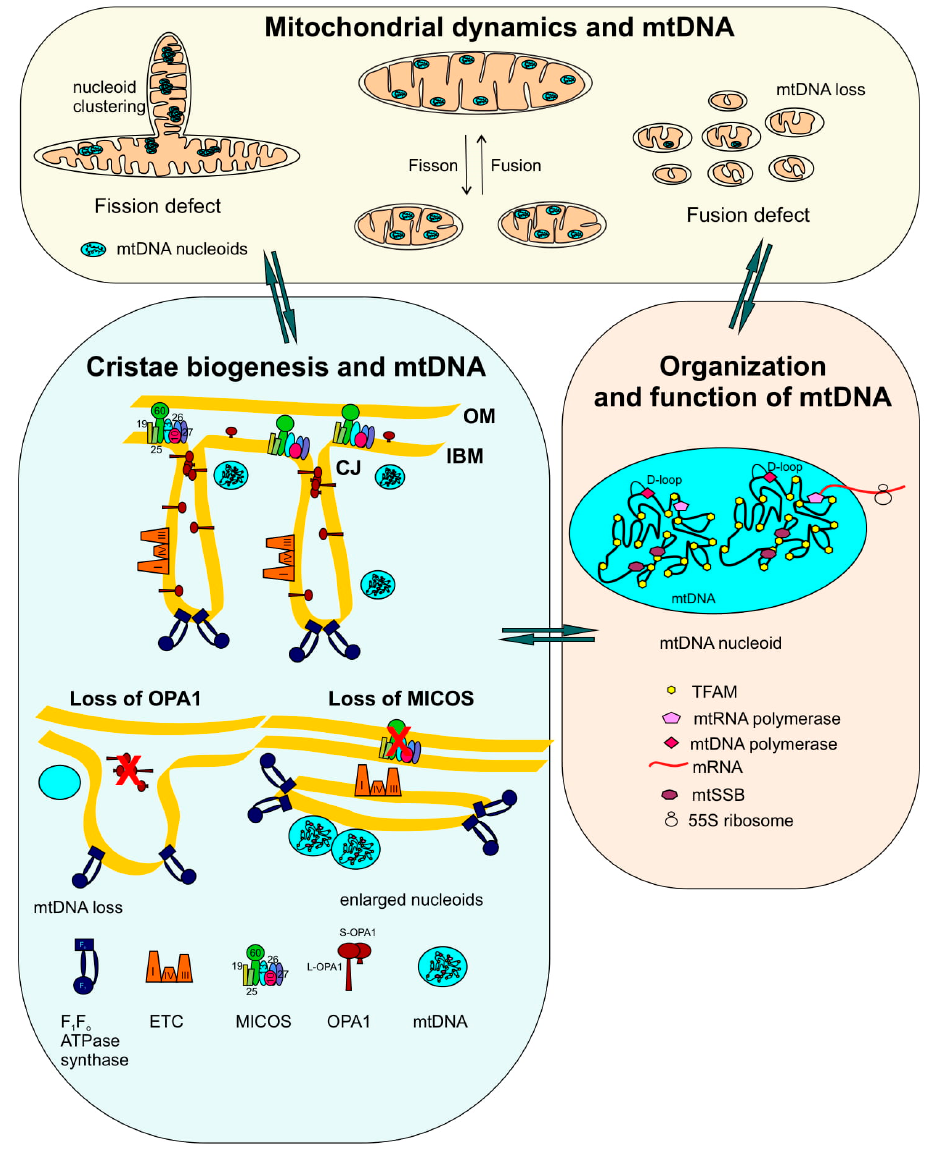
Figure 1. Functional interplay of mitochondrial dynamics, cristae biogenesis and mtDNA integrity: The scheme describes that the balance between mitochondrial dynamics, cristae biogenesis and mtDNA structure helps to manage integrity and function of mitochondrial DNA. Mitochondrial dynamics comprising fission and fusion cycles helps in redistribution and complementation of mtDNA within mitochondria. Lack of fusion causes subsequent loss of mtDNA from the fragmented mitochondria, whereas accumulation of aggregated nucleoids is observed in elongated mitochondria generated during a fission defect. Relationship between mitochondrial dynamics and cristae biogenesis and mtDNA organization is evident by several examples where the loss of fusion or fission concurrently shows defective cristae and mtDNA loss. Altered morphology of mitochondria is observed with mtDNA aberrations during cristae biogenesis defects. The internal mitochondrial structure is modulated by the following key players regulating cristae shape: OPA1 oligomers, MICOS, and F 1 F o ATPase synthase. Chronic loss of OPA1 is accompanied by cristae defects as well as mtDNA loss. Depletion of MIC60 results in loss of CJs together with accumulation of enlarged nucleoids. The function and organization of mtDNA nucleoids is schematically depicted. On average, 1.4 mtDNA molecules are present per nucleoid which also contains associated proteins required for compaction, replication and transcription. ETC, electron transport chain (complex II is not